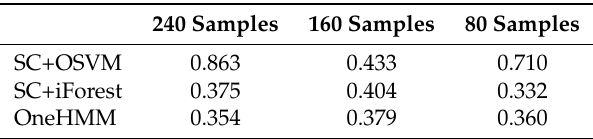
Table 2. Area under the ROC curve (AUC) values with different algorithms and different numbers of training